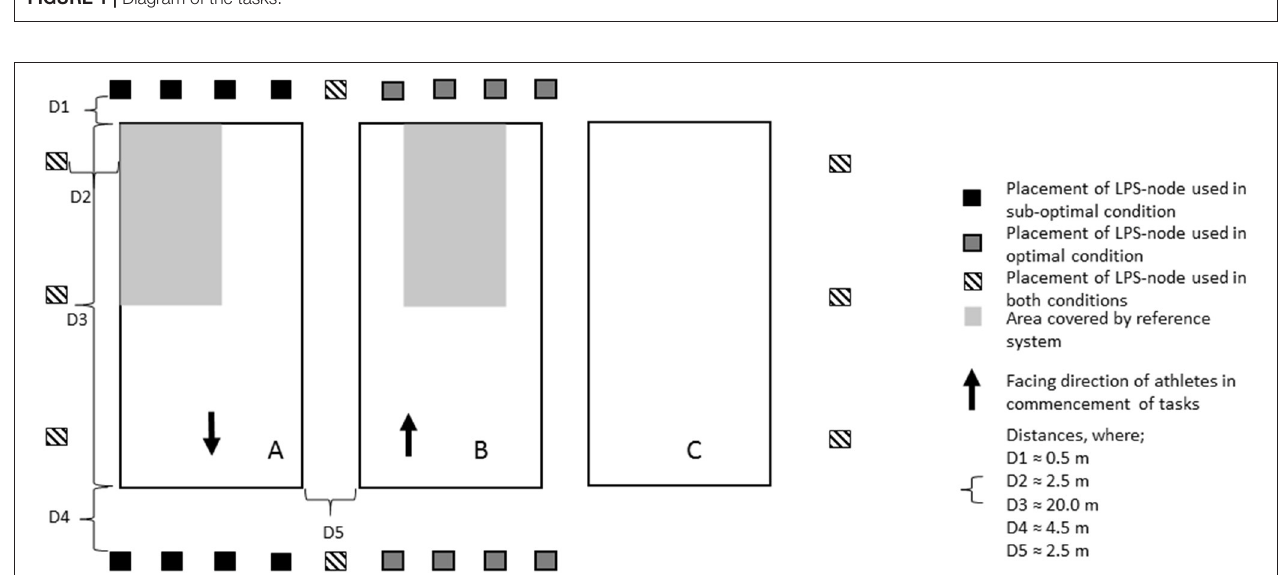
FIGURE 2 | Setup of nodes around the handball court. The anchor nodes were suspended ∼ 3m above the